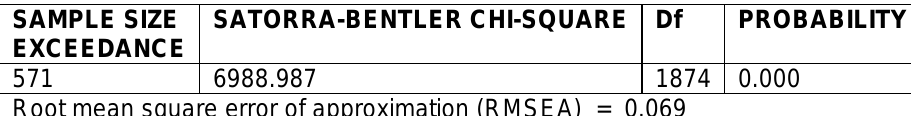
Table 5: results of the confirmatory factor analysis SAMPLE